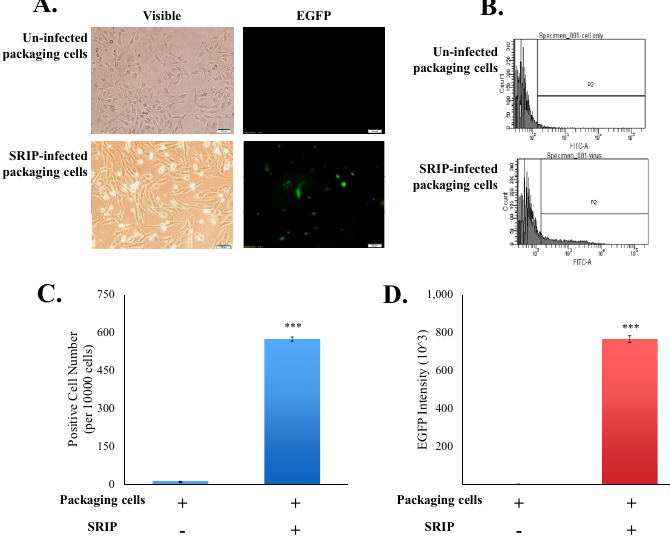
Figure 5. Analysis of the infectivity of JEV-EGFP SRIPs in packaging cells. The cytopathic effect and the green fluorescence of SRIP-infected cells were photographed using immunofluorescent microscopy 36 h post infection ( A ). Un ‐ infected and infected packaging cells were harvested, washed, fixed, and then analyzed using flow cytometry with excitation at 495 nm and emission at 520 nm ( B ). EGFP ‐ positive cells ( C ) and green fluorescent intensity ( D ) of infected cells were recorded, respectively. ***, p ‐ value < 0.001 compared with un ‐ infected packaging cells.